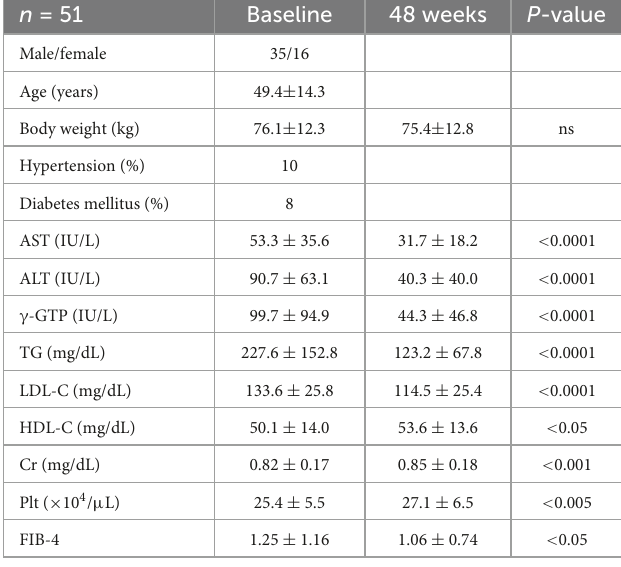
TABLE 2 Characteristics of patients measured liver stiffness using SWE at baseline and after 48 weeks of pemafibrate